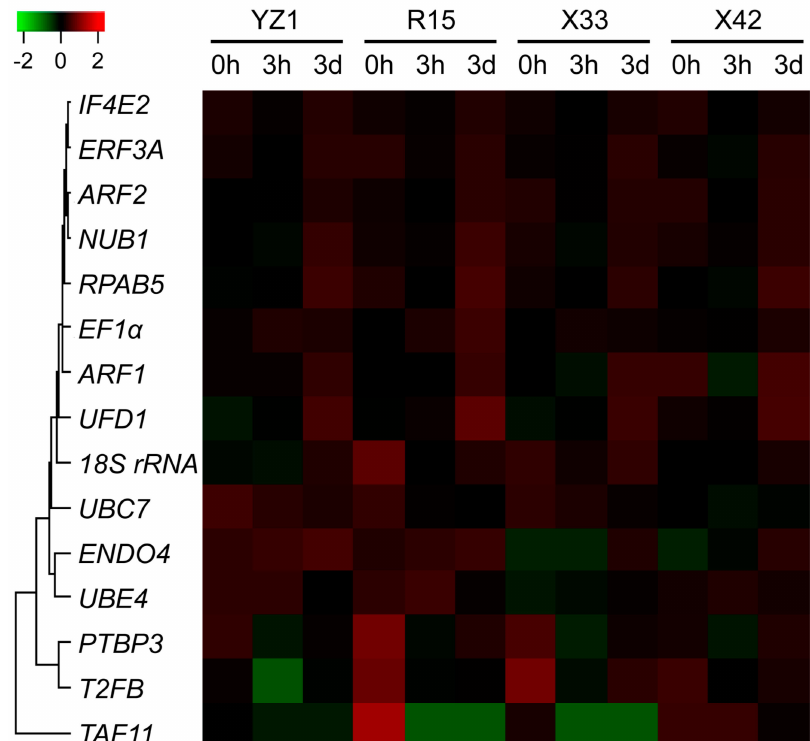
Figure 1. FPKM-based heatmap of the 15 candidate reference genes during three induction stages in four cotton cultivars. Fifteen candidate reference genes were selected from the Gossypium hirsutum transcriptome datasets with the screening conditions of q-value ≥ 0.05, FPKM ≥ 5, and | log2FoldChange | < 1. Higher or lower FPKM of candidate reference genes were colored by red or green in four cotton cultivars, respectively. The color bar was shown at the upper apex. The visualized heatmap was generated using the R package based on the FPKM from the G. hirsutum transcriptome datasets. The sequences of the 15 candidate reference genes, including 18S rRNA , ENDO4 , EF1 α , ADP-ribosylation factor 1 ( ARF1 ), ADP-ribosylation factor 2 ( ARF2 ), eukaryotic peptide chain release factor 3A ( ERF3A ), eukaryotic translation initiation factor isoform 4E-2 ( IF4E2 ), NEDD8 ultimate buster 1 ( NUB1 ), polypyrimidine tract-binding protein homolog 3 ( PTBP3 ), RNA polymerases I, II, and III subunit ( RPAB5 ), transcription initiation factor (IIF), beta subunit ( T2FB ), TBP-associated factor 11 ( TAF11 ), U-box domain-containing protein ( UBE4 ), ubiquitin carrier protein 7 ( UBC7 ), and ubiquitin fusion degradation 1 ( UFD1 ), were obtained from NCBI GenBank nucleotide sequence database with the detailed information of the gene names and